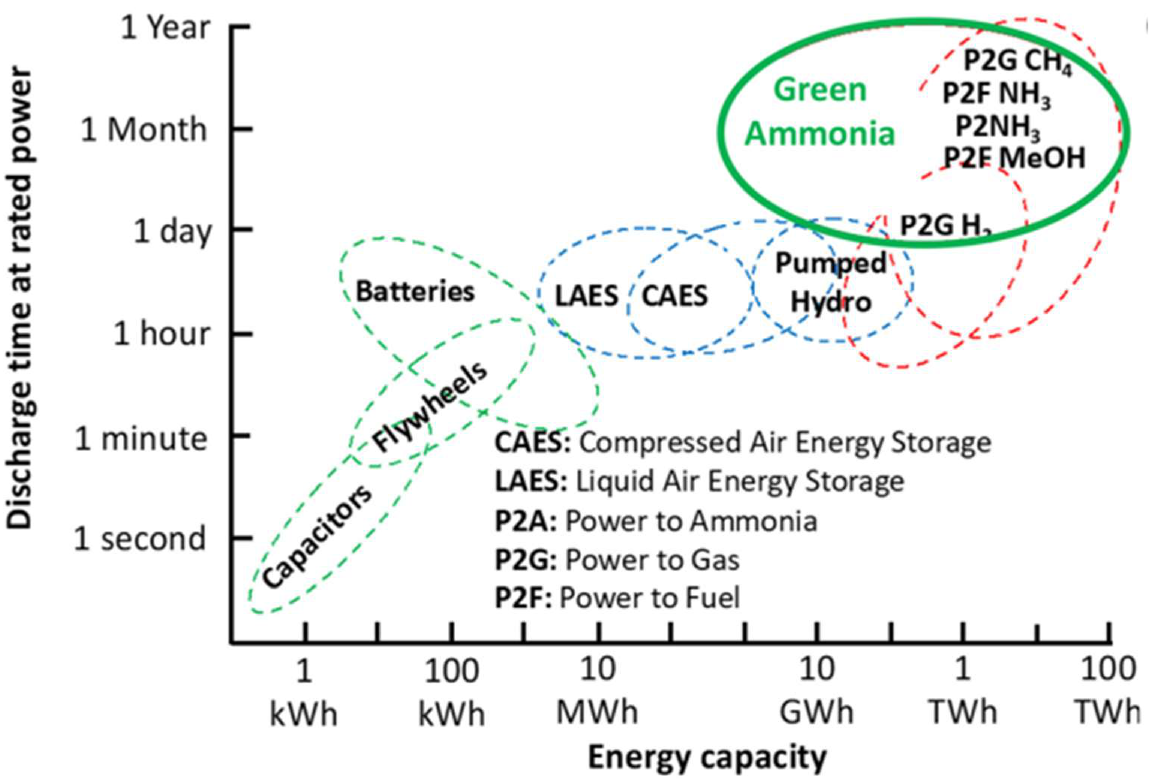
Figure 6. Energy storage capacity and discharge time of different storage technologies [44] (published under the terms of the Creative Commons CC-BY license).